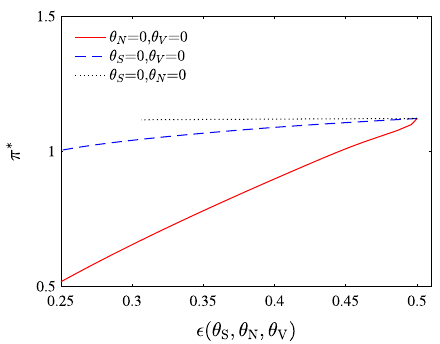
Fig. 3 Optimal portfolio choice in stock market as a function of the DEP using different θ S , θ N and θ V . The solid, dashed and dotted line represent change of ambiguity aversion with respect to price diffusion, jump and volatility diffusion while keeping the other two parameters as zero,